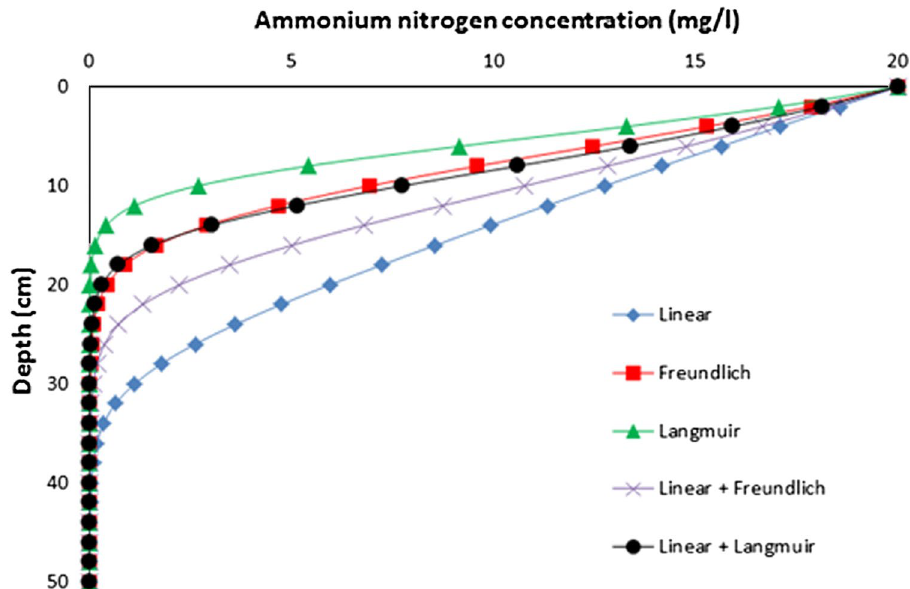
Fig. 4 Concentration profile for ammonium nitrogen with linear, Freundlich and Langmuir isotherms at the end of 50 days of wastewater application (refer to Tables 2 and 3 for other